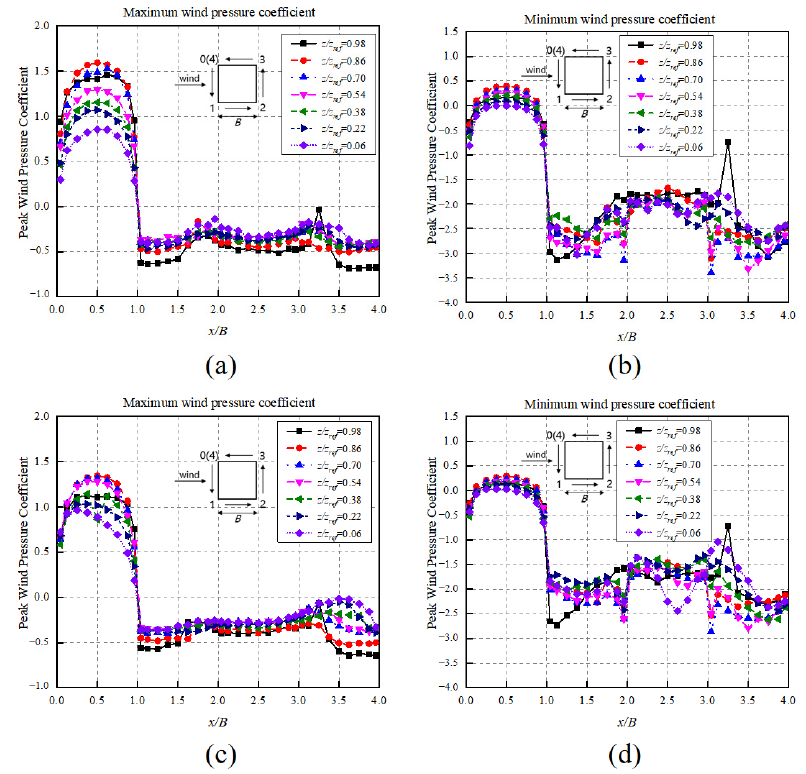
Figure 12. Distributions of peak pressure coefficients: ( a , b ) CWF2-0°; and ( c , d ) TWF20-0°.